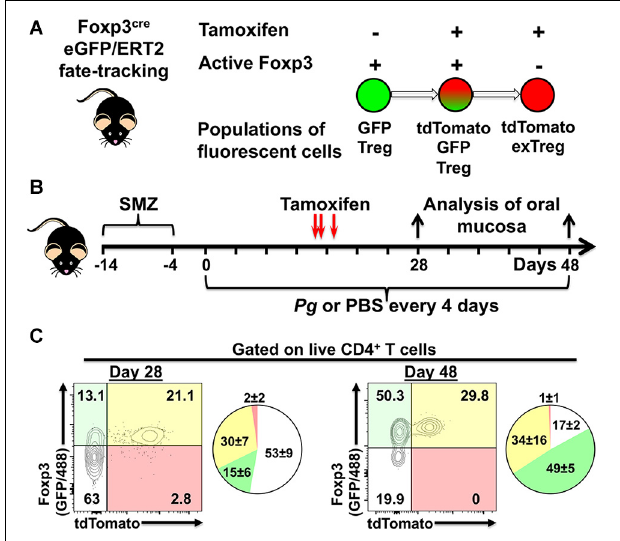
FIGURE 5 | Experimental design to identify populations of fluorescently labeled Treg cells. (A) Potential populations of fluorescent Treg cells found in tamoxifen-treated Foxp3 cre -GFP//ERT2 fate-tracking mice. (B) Experimental timeline for administration of P. gingivalis and, tamoxifen in experimental animals. (C) Representative flow cytometry plots gated on live CD4 + T cells from the oral mucosa of mice treated with tamoxifen and inoculated with Pg for 28 or 48 days. CD4 + T cells were identified as Zombie Aqua lo , CD45 + , CD3 + , CD4 + , β TCR + , CD8 α − . To augment GFP expressed from the Foxp3 promoter in these mice, cells were additionally stained with anti-mouse Foxp3 mAb conjugated to AF488. Numbers within the quadrants indicate% of the total CD4 + T cells gate. Summary pie charts show mean% ± SEM N = 4